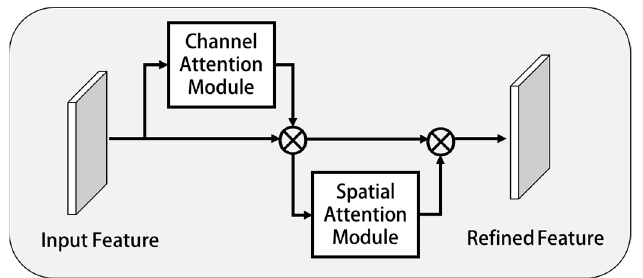
Figure 4. Convolution attention mechanism.